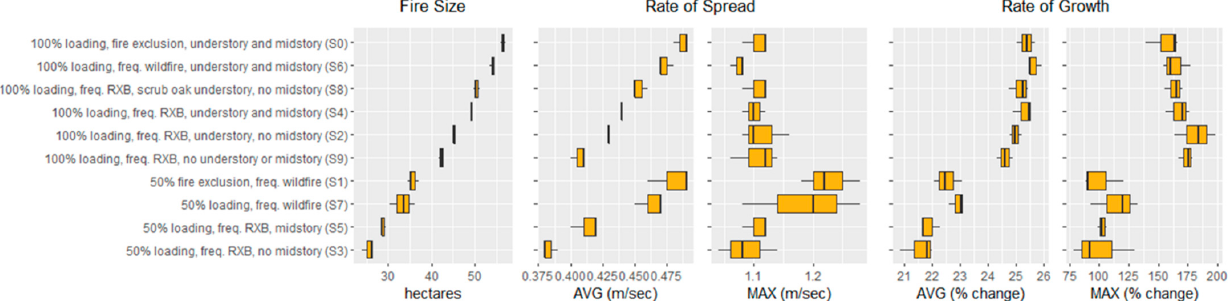
Figure 8. Fire size, rate of spread, and rate of growth results for 10 simulation scenarios differing in prior wildfire and prescribed fire management histories and fuel loading. Boxes refer to 1st–3rd quartile, thick vertical lines within boxes refer to median, and whiskers indicate minimum and maximum values of data distributions.